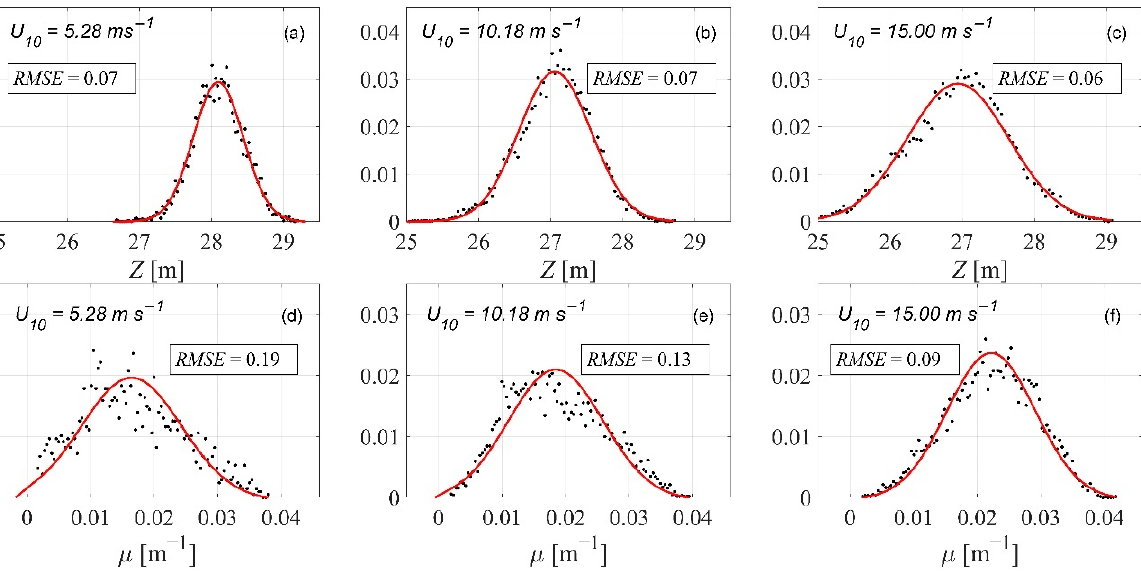
Figure 7. The attenuation coefficient varies with U 10 . Grey dots are the laser intensity attenuation coefficient with systemic error. Black dots are the laser intensity attenuation coefficient after quality control.